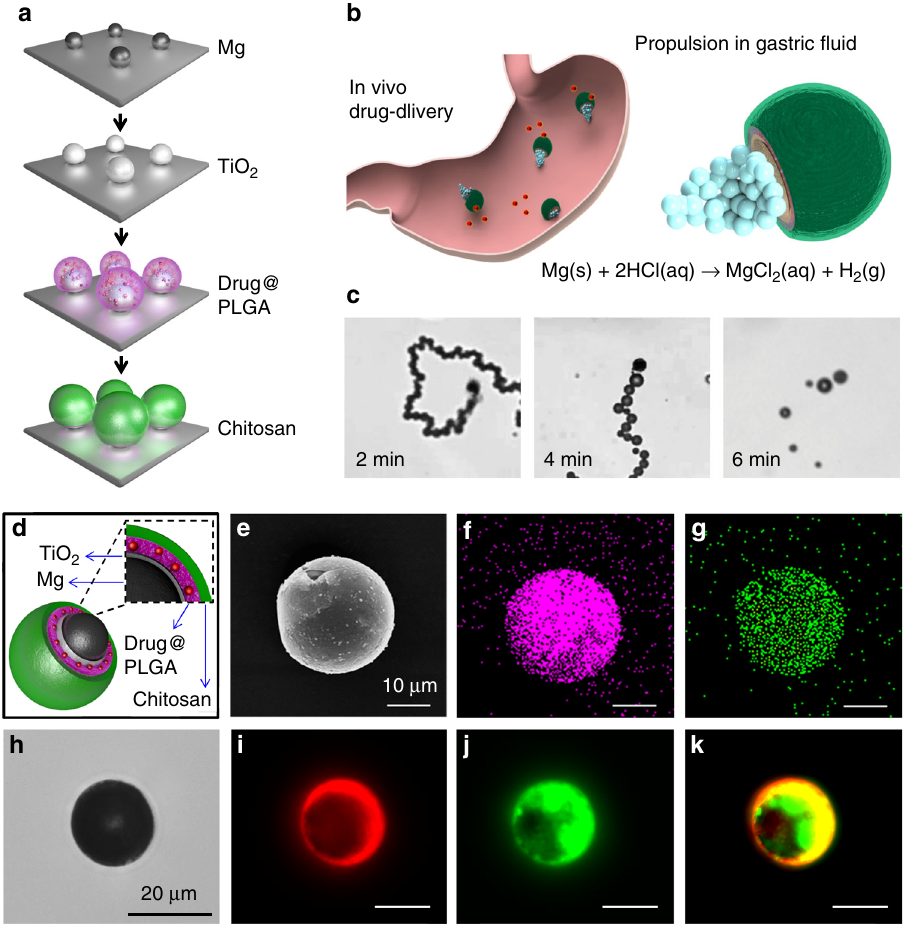
Fig. 1 Synthesis and characterization of drug-loaded Mg-based micromotors. a Schematic preparation of the micromotors: Mg microparticles dispersion over a glass slide, TiO 2 atomic layer deposition ( ALD ) over the Mg microparticles, drug-loaded PLGA deposition over the Mg-TiO 2 microparticles, and Chitosan polymer deposition over the Mg-TiO 2 -PLGA microparticles. b Schematic of in vivo propulsion and drug delivery of the Mg-based micromotors in a mouse stomach. c Time-lapse images (2 min intervals, taken from Supplementary Movie 3) of the propulsion of the drug-loaded Mg-based micromotors in simulated gastric fl uid (pH ~1.3). d Schematic dissection of a drug-loaded micromotor consisting of a Mg core, a TiO 2 shell coating, a drug-loaded PLGA layer, and a chitosan layer. e Scanning electron microscopy ( SEM ) image of a drug-loaded Mg-based micromotor. f , g Energy-dispersive X-ray spectroscopy ( EDX ) images illustrating the distribution of f magnesium and g titanium in the micromotor. h – k Microscopy images of dye-loaded Mg-based micromotor: h optical image and fl uorescence images showing the dye-loaded Mg-based micromotors in the i DiD channel (PLGA layer), j FITC channel (chitosan layer), along with an overlay of the two channels